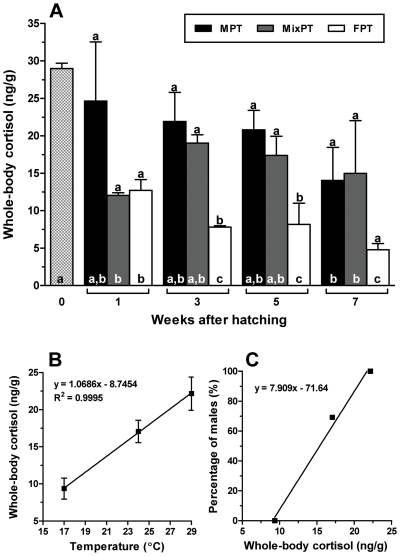
A) Concentration of endogenous cortisol in larvae reared at masculinizing (MPT, 29°C), mixed-sex-producing (MixPT, 24°C), and feminizing (FPT, 17°C) temperatures between 0 and 7 wah. Larvae reared at the MPT and MixPT showed higher cortisol values than those at the FPT between 3 and 5 weeks, a period considered as critical for gonadal sex determination in pejerrey. Different letters inside and above the bars indicate statistically significant differences between weeks for the same temperature and between treatments on the same week, respectively (One-way ANOVA followed by the Tukey test; P≤0.05; GraphPad Prism v.4.00). B) Relation of rearing temperature and the concentration of endogenous cortisol in individual larvae between 1 and 5 weeks after hatching. C) Relation of the mean concentration of endogenous cortisol between 1 and 5 weeks after hatching and the percentage of males.